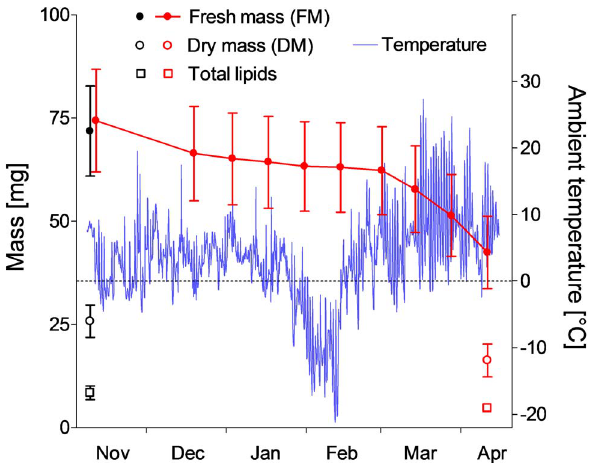
Figure 1. Fresh mass, dry mass, total lipid mass. Gradual losses of FM, DM and total lipid mass (all masses are in mg) in caterpillars of Cydia pomonella during their overwintering in the field in 2011/2012. Each point is the mean 6 S.D. ( n =10 individuals). Black symbols are for larvae that were analyzed at the beginning of November, while red symbols are for larvae, in which gradual loss of FM was measured in approximately 14 d-intervals throughout the cold season and their DM and total lipids were analyzed in April (see text for details). The larvae were located on tree trunks (see text for details) and the course of ambient temperatures was recorded in 2